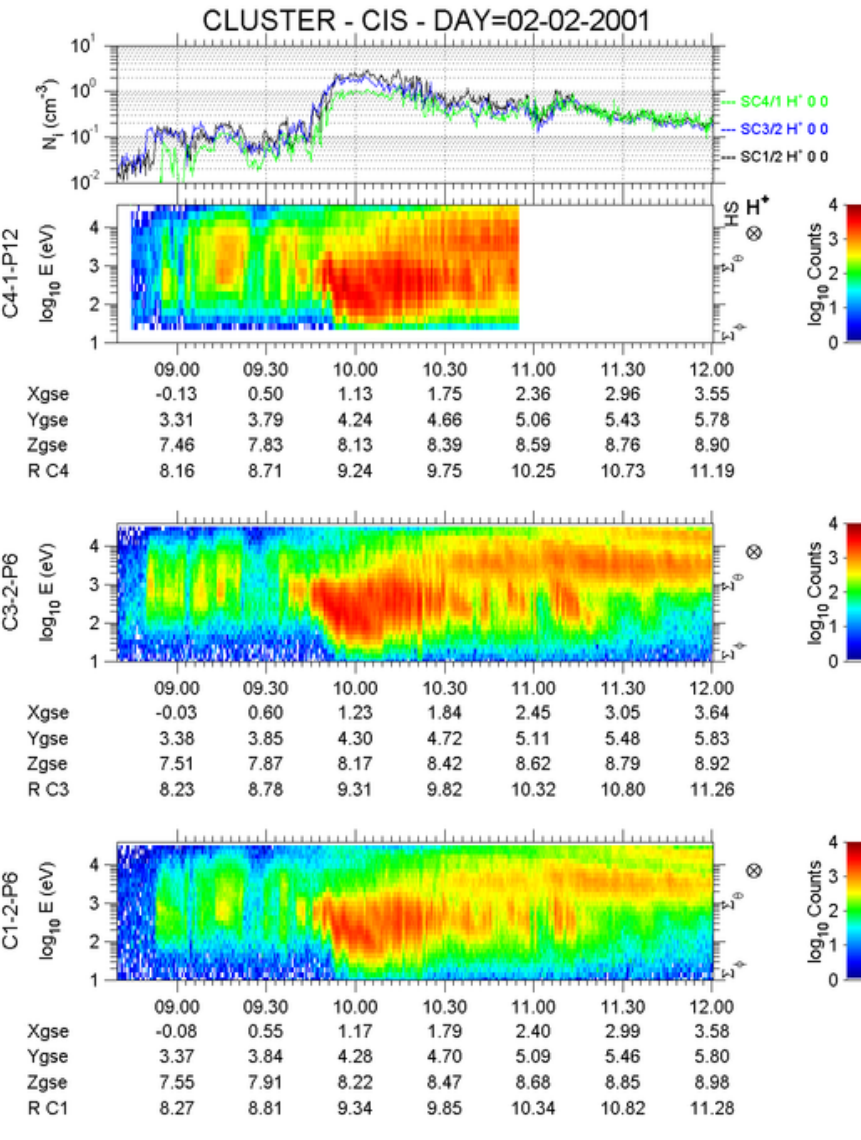
Fig. 6. Cluster data on 2February2001. From top to bottom, proton density from 3 spacecraft and ion spectrograms recorded by CIS instrument on board each of the 3 spacecraft: S/C 4, S/C 3 and S/C